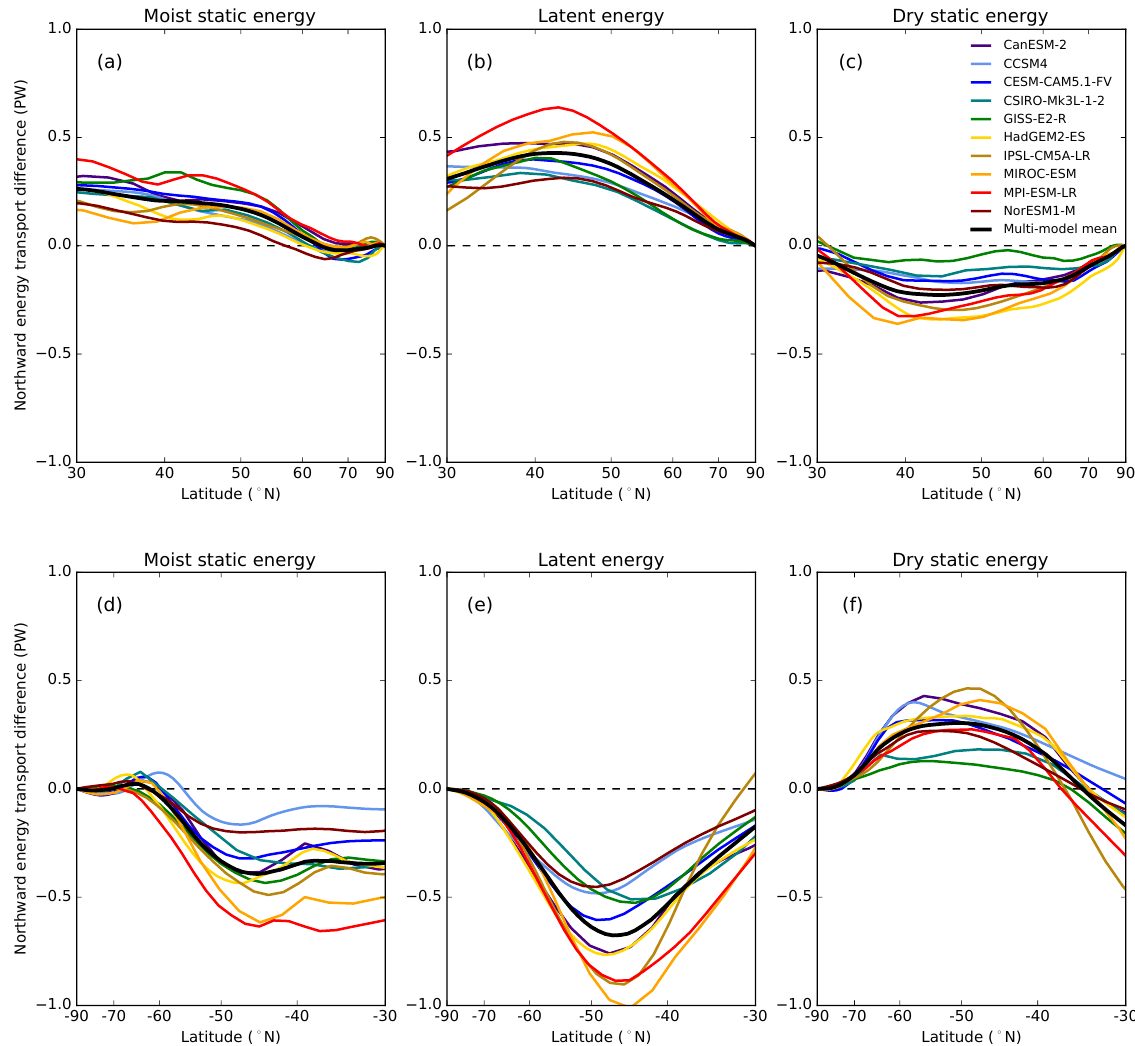
Figure 2. As in Fig. 1 but for abrupt4xCO2 – piControl.